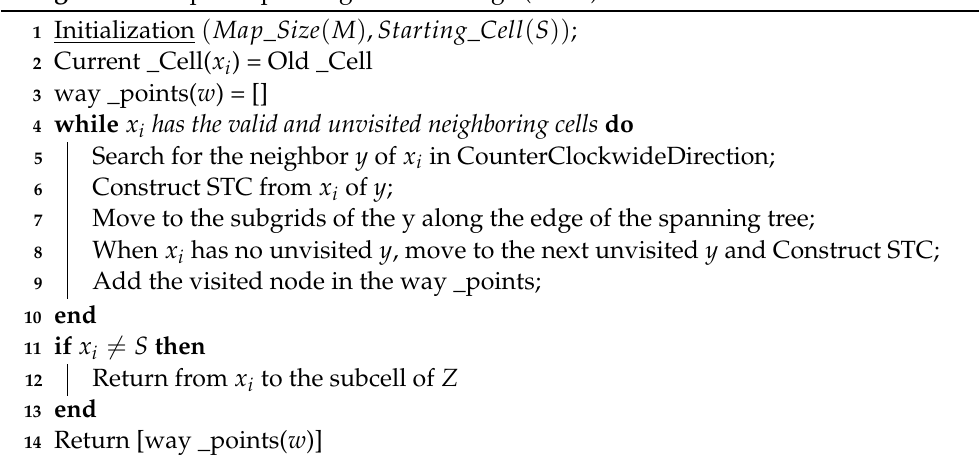
Algorithm 1: Spiral Spanning Tree Coverage (SSTC)